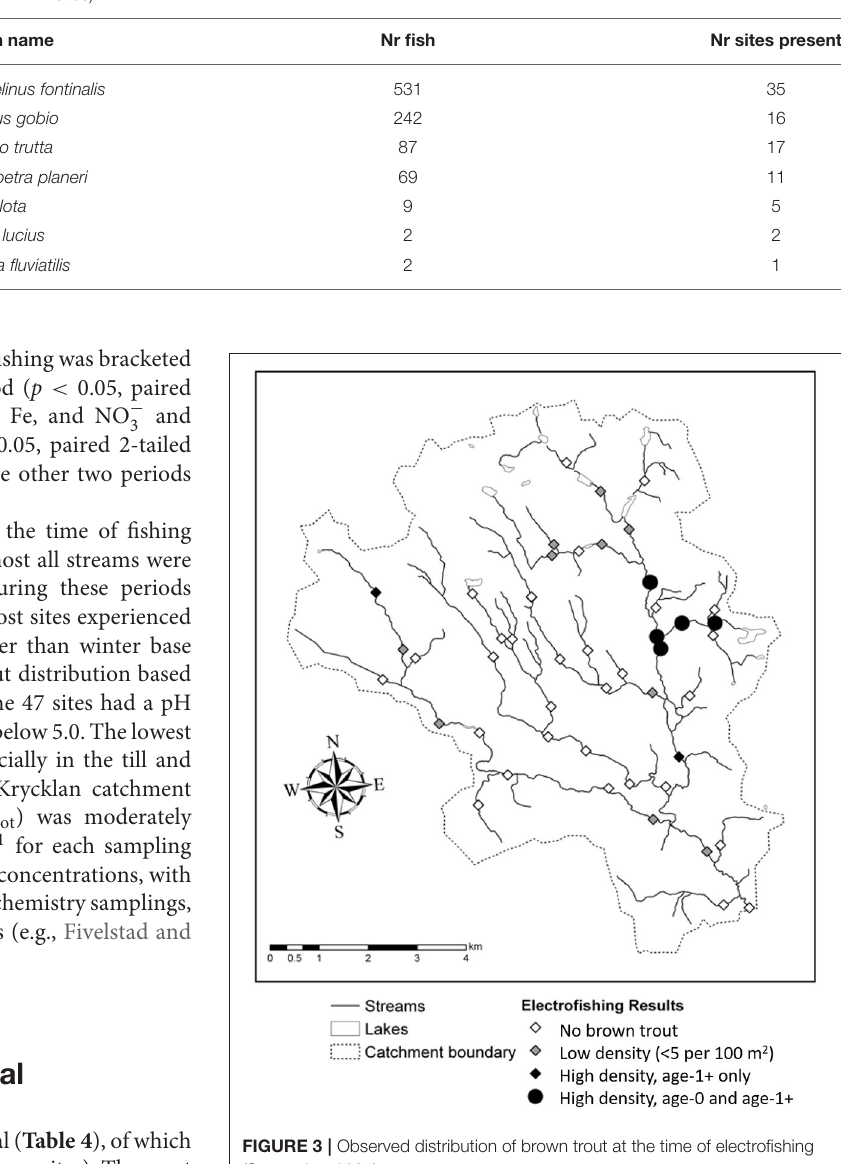
TABLE 4 | Fish caught during the electrofishing survey ( N = 47 sites).